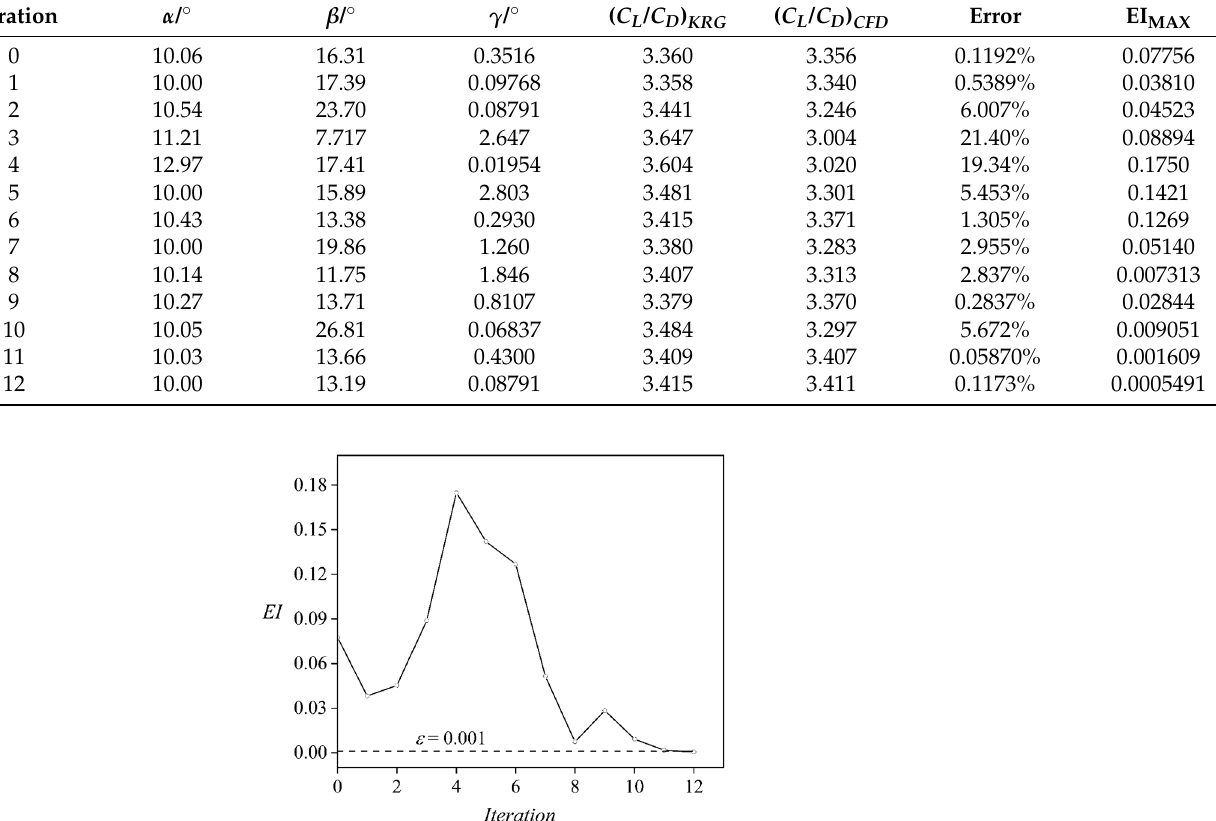
Table 1. Results of the unconstrained optimization. The iteration indicates the update of the dynamic Kriging model.